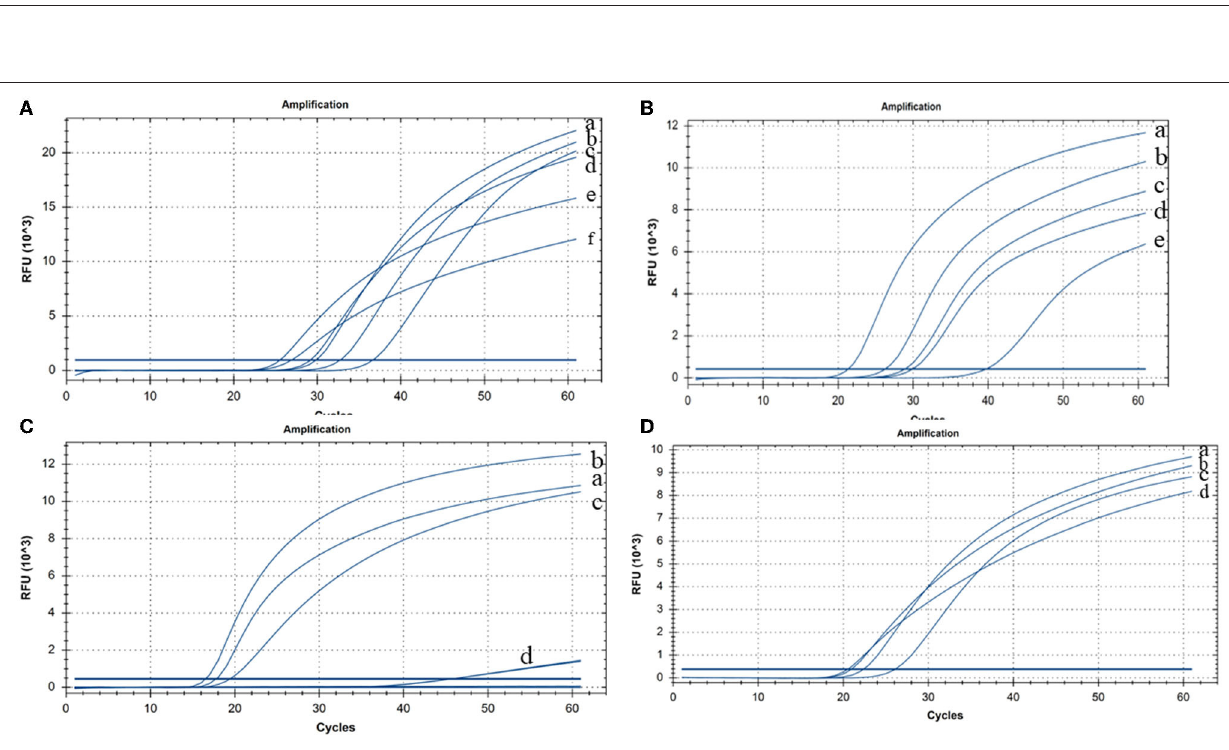
Frontiers in Veterinary Science | www.frontiersin.org